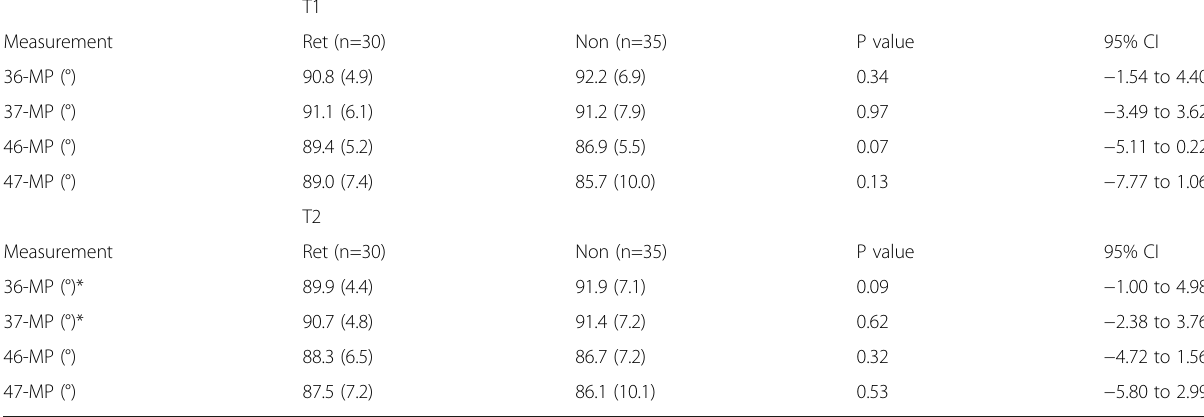
Table 2 Means, SD in parentheses of the molar inclination angles and movement percentages at T1 and T2 and P values, 95% CI of intergroup differences (unpaired t-test): Ret, retention group; Non, non-retention group; *, Mann – Whitney U test